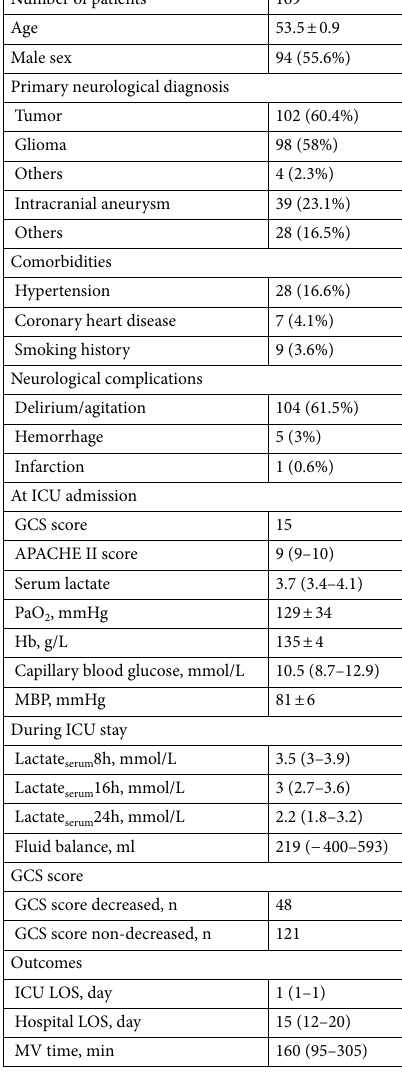
Table 1. Characteristics of patients in the study. Others: CAS (carotid artery stenting) + A-V M(Arteriovenous malformation) + epilepsy; PO2: partial pressure of oxygen; Hb: hemoglobin; ICU LOS: ICU length of stay; Hospital LOS: hospital length of stay; GOSE: extended Glasgow outcome